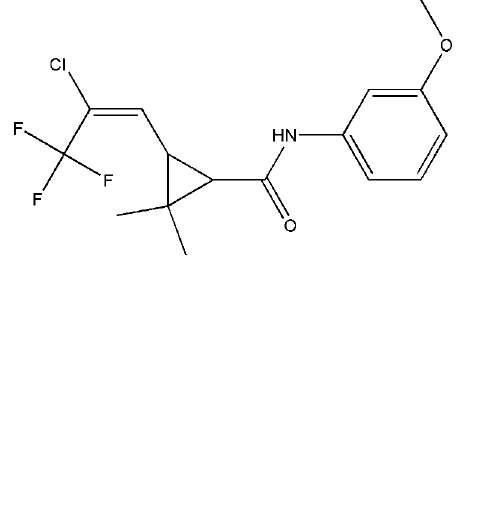
The title compound, C H ClF NO , was synthesized from 16 17 3 2 3-[( E )-2-chloro-3,3,3-trifluoroprop-1-enyl]-2,2-dimethylcyclo- Hydrogen-bond geometry (A˚ , (cid:1) propanecarboxylic acid and 3-methoxybenzenamine. The propenyl and carboxamide substituents lie on the same side of the cyclopropane ring plane, with the two methyl substituents on either side of the plane. The benzene ring makes a dihedral angle of 76.4 (3) (cid:1) with the plane of the cyclopropane ring. The crystal structure involves intermole- cular N—H (cid:2) (cid:2) (cid:2) O hydrogen bonds. Related literature For related literature, see: Liu & Yan (2007); Punja (1981).